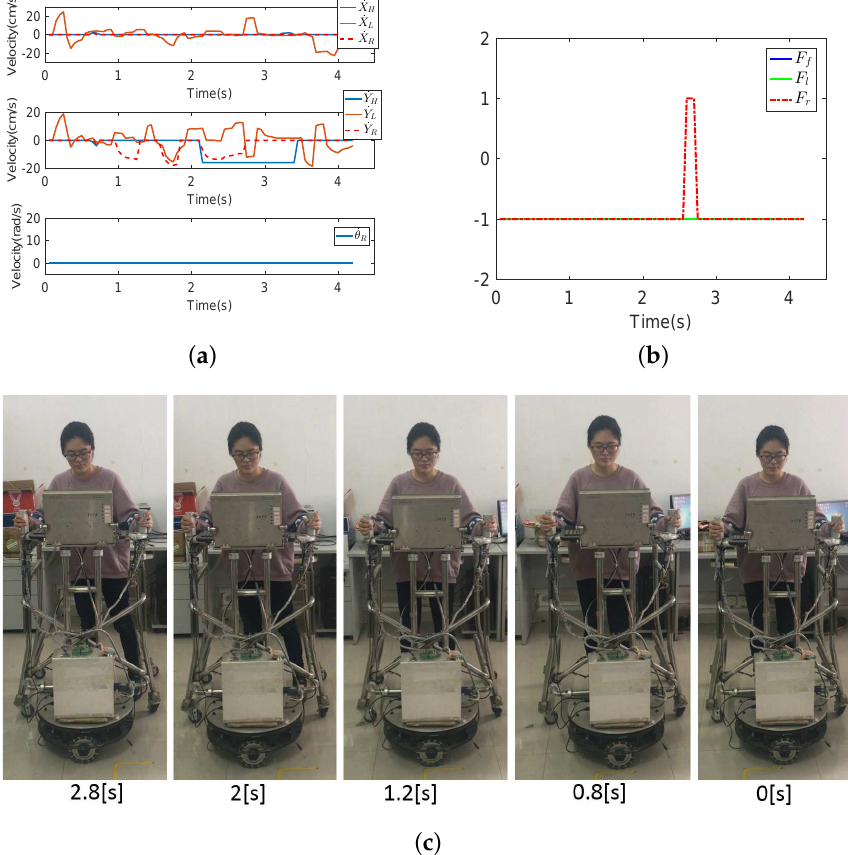
Figure 15. The results of the falling to the right experiment. ( a ) The HMI velocities estimated by HMI Estimation Algorithms I and II and the actual robot moving velocities by the KF-based coordinated motion fusion algorithm when the subject falls to the right. ( b ) The result of fall mode detection when the subject falls to the right. ( c ) The process of falling to the right. Figure 16 shows the mean average relative distance when falling is detected (error bar) in seven subjects. The blue error bar is the mean average relative distance when the user falls forward. The green error bar is the mean average relative distance when the user falls to the left. The yellow error bar is the mean average relative distance when the user falls to the